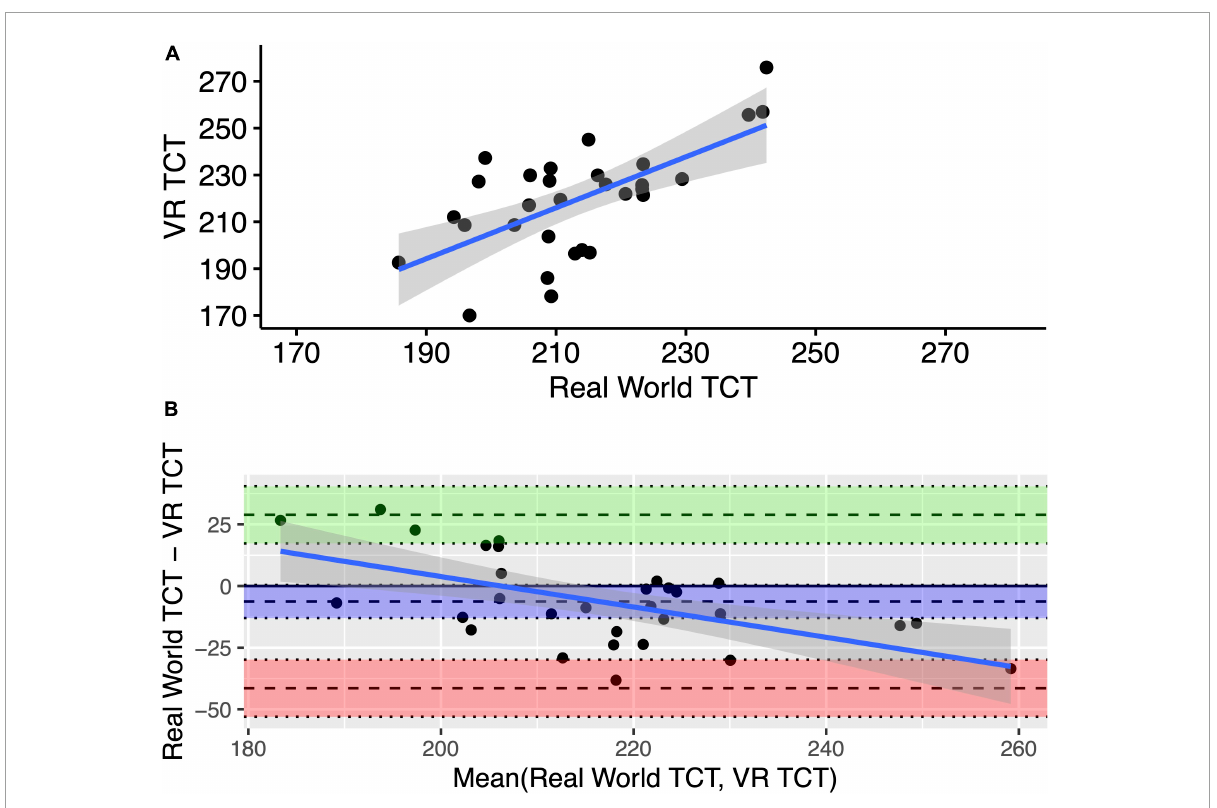
FIGURE5 Raw data with least-squares regression line (A) and Bland–Altman plot (B) for the mean of six tests for distance traveled from the real-world and VR triangle competition tests from session 2. TCT stands for triangle completion